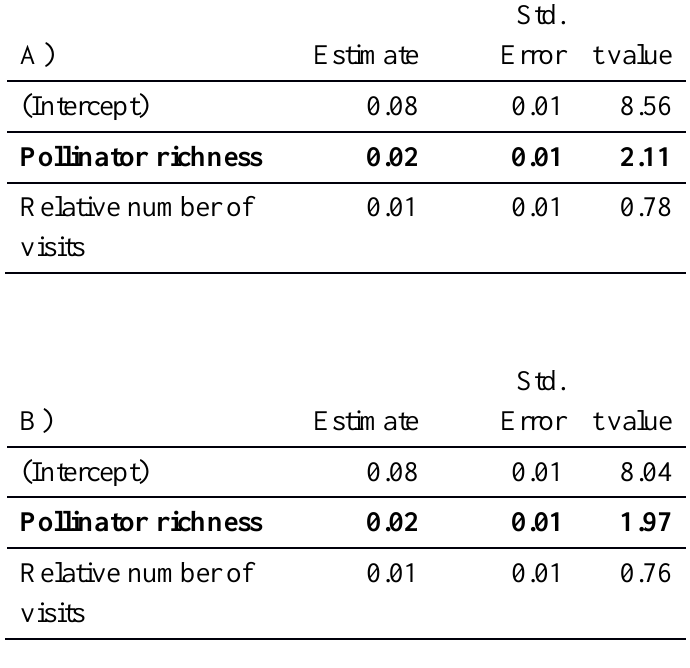
Table S5. Results of GLM showing effect of simple visitation metrics on A) site-level average fruit weight based on best model selected and B) the same analysis removing one site that has a particularly large pollinator richness value to test whether this point might be driving the